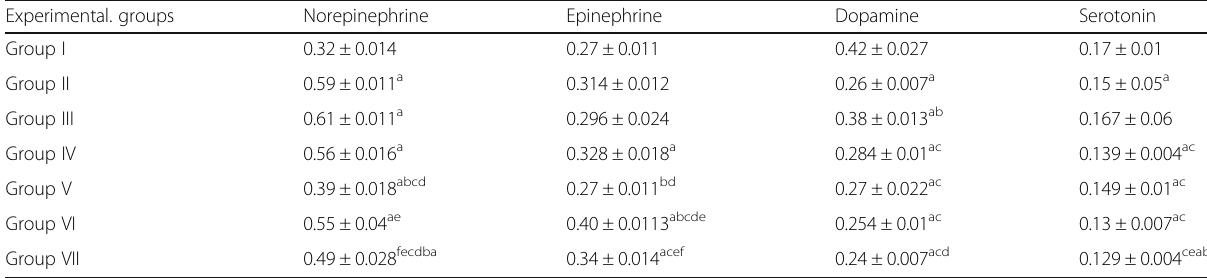
Table 5 The levels of monoamines ( μ g/g) in hippocampus of male offspring in groups I to VII, 70 days postnatal. Data were presented as a mean of eight rats ± SEM Experimental.